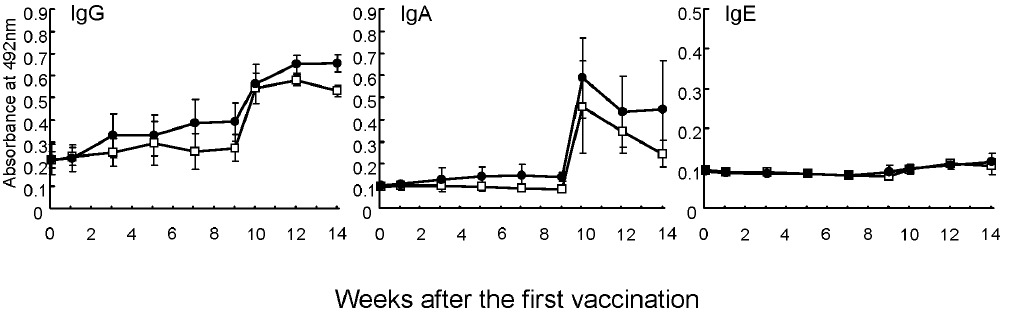
Figure 4. Serum antibody response in dogs immunized via the nasal and oral route with SRf1. Serum antibody responses against SRf1 evoked by nasal and oral immunization were detected by ELISA. The closed circle and open square indicate groups immunized with SRf1 plus adjuvant and adjuvant alone, respectively. Compared with the adjuvant control, an increase in the IgG response was detected in the group immunized with SRf1. No significant IgA or IgE responses were detected during immunization. A sharp increase in IgG and IgA responses were detected in each group after challenge infection.